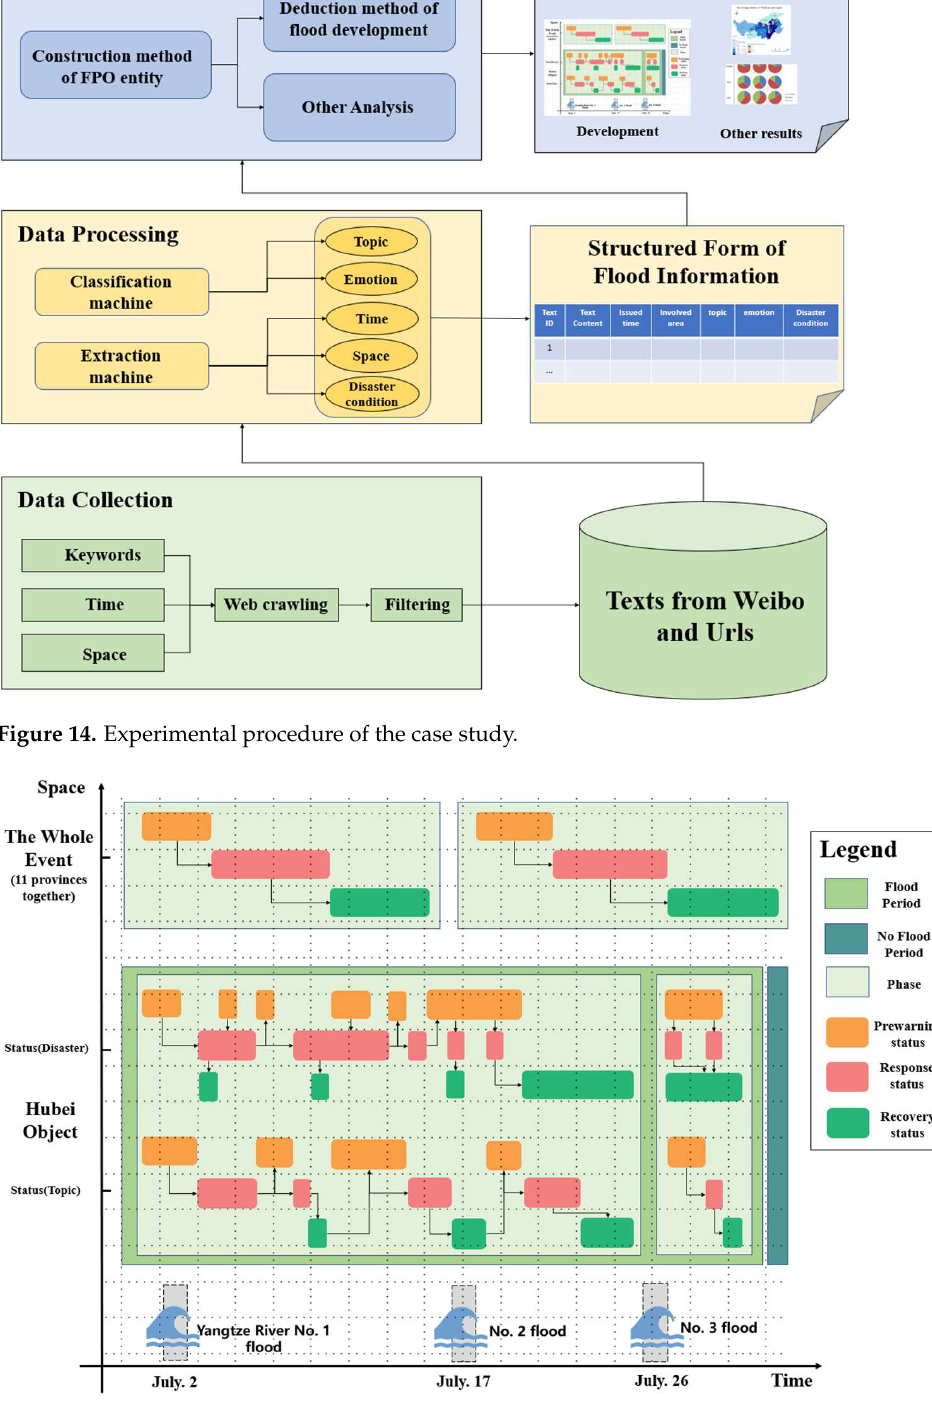
Figure 15. The flood development process (using Hubei as an example).